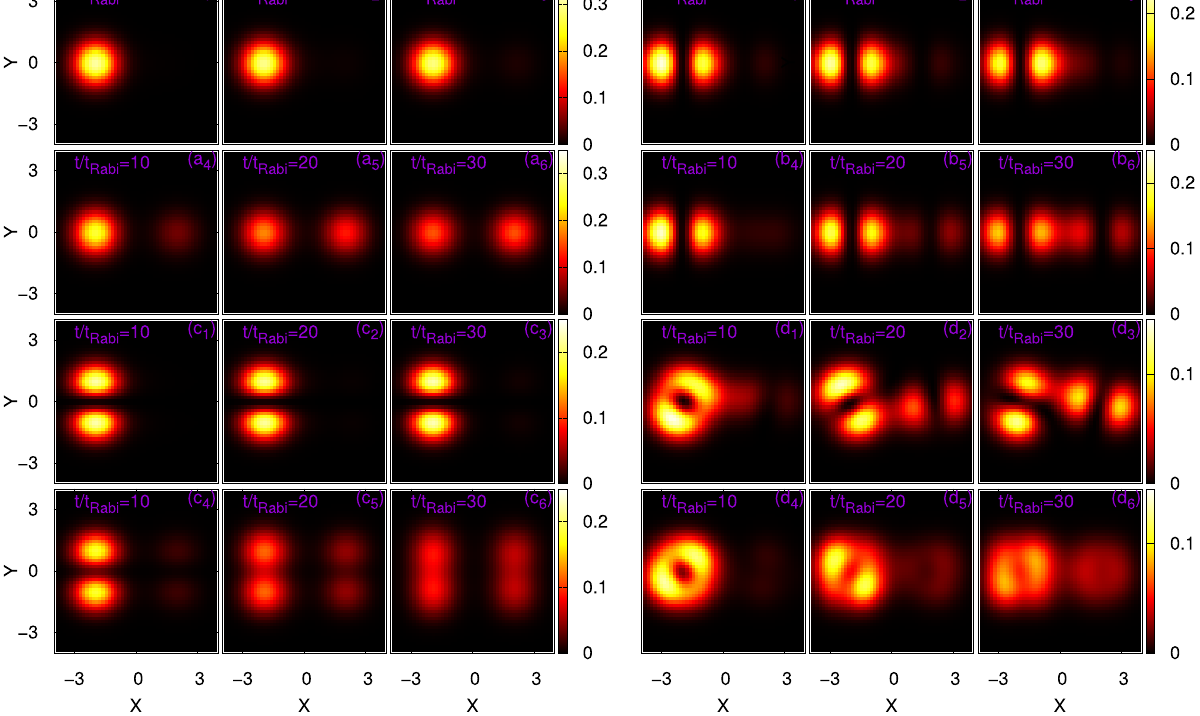
Figure 11. Time evolution of the mean-field (first and third rows) and many-body (second and fourth rows) 0.01 π and the number of density oscillations in a symmetric 2D double-well. The interaction parameter is � = 10 . Shown are snapshots for the densities per particle at t 10 t bosons is N Rabi (first and fourth columns), = = 20 t 30 t Rabi (second and fifth columns), and Rabi (third and sixth columns) for the initial states (cid:31) G , (cid:31) X , (cid:31) Y , and 6 time-adaptive orbitals for (cid:31) (cid:31) V . The MCTDHB computation is performed with M G and (cid:31) X , and with = 10 time-adaptive orbitals for (cid:31) M Y and (cid:31) V . The quantities shown are =